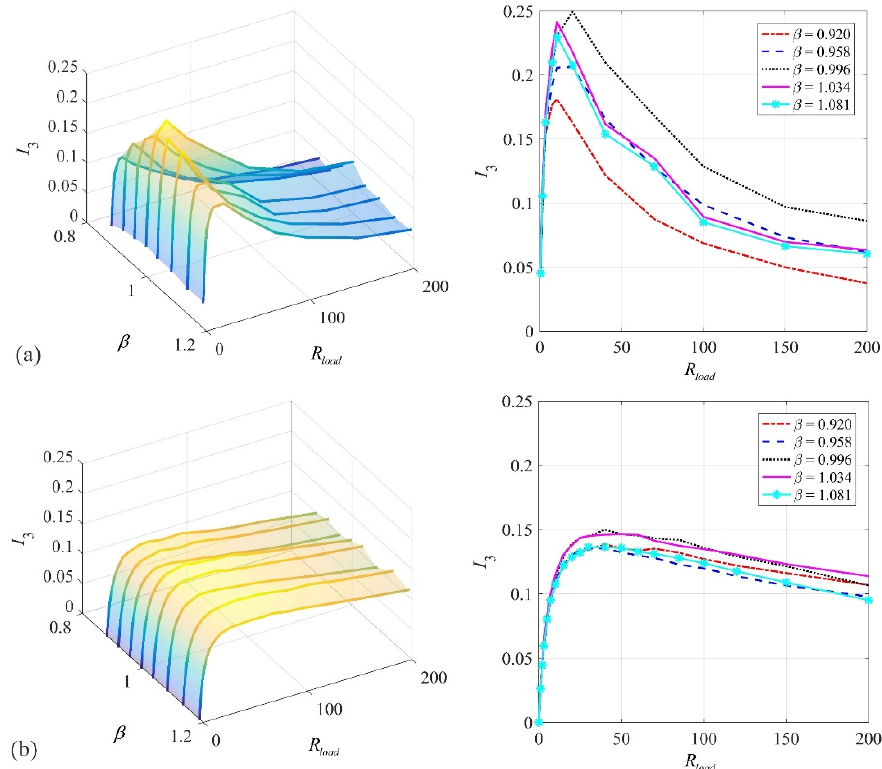
Figure 19. 3D and 2D plots of I 2 with µ = 0.154: ( a ) experimental result; ( b ) simulation result.